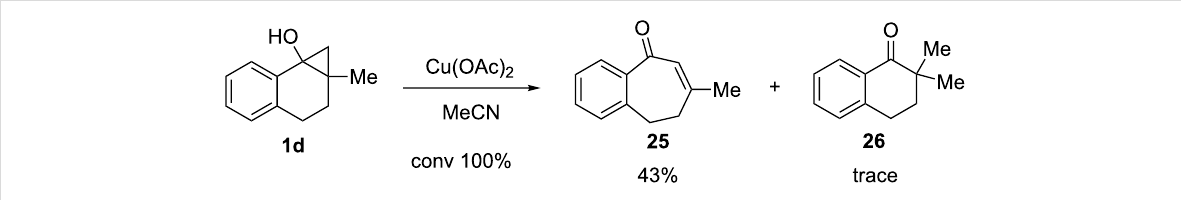
Scheme 11: Reaction of cyclopropanol 1d with various Cu(OAc) 2 .